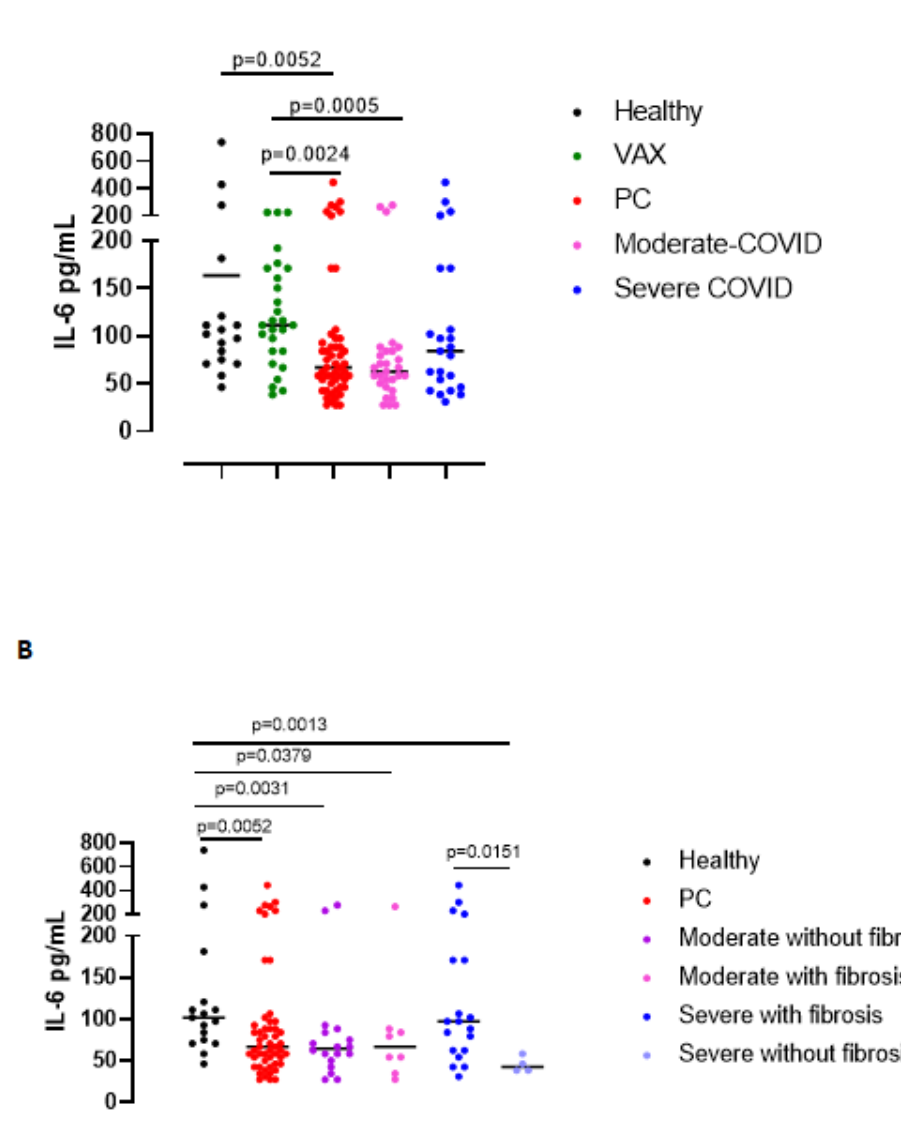
Figure 2. Circulating levels of IL-6 in moderate and severe PC patients ( A ), as well as in moderate and severe PC patients with or without fibrosis-like symptoms ( B ) were reduced compared to healthy (black dots) and vaccinated (VAX, green dots) subjects. ( A ) Plasma levels of IL-6 were measured according to the grade of the disease (moderate or severe, pink and blue dots, respectively) and ( B ) to the establishment of lung fibrosis-like symptoms (moderate or severe PC patients with or without fibrosis, pink or blue dots and purple and bright blue dots, respectively). Data are expressed as median. Statistical analysis was performed according to the Mann–Whitney U test.